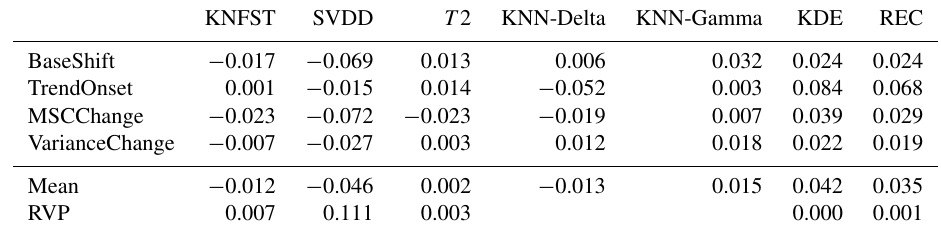
Table 1. Average AUC difference of the anomaly detection algorithms from the UNIV control for each event type. KNFST SVDD T 2 KNN-Delta KNN-Gamma KDE REC BaseShift − 0.017 − 0.069 0.013 TrendOnset 0.001 − 0.015